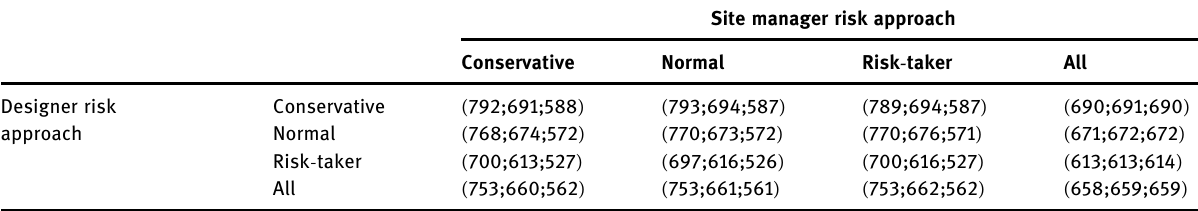
Table 4: Average project completion cost ( in thousands of euros ) for various worker experience ratings ( little; average; high )